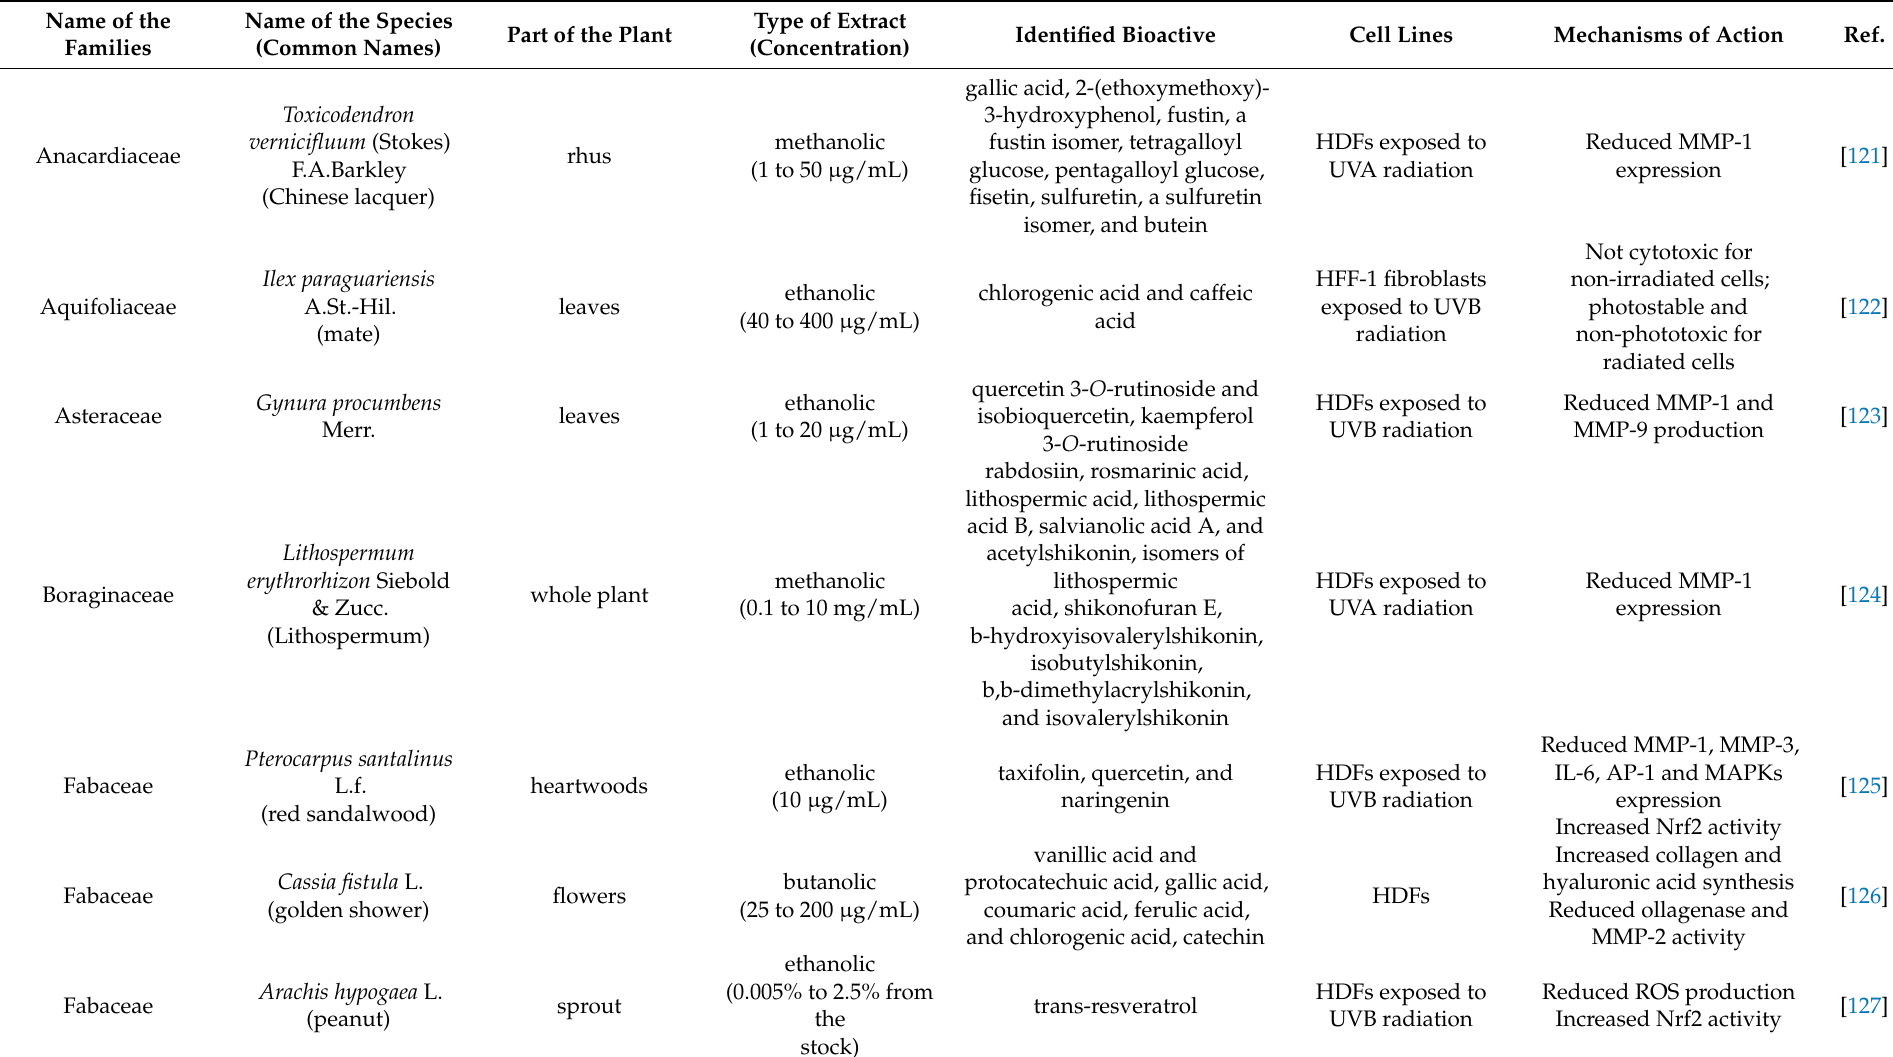
Table 3. Selected plant extracts from different species with identified phenolic compounds and their in vitro effect on dermal fibroblast cells as anti-photoaging